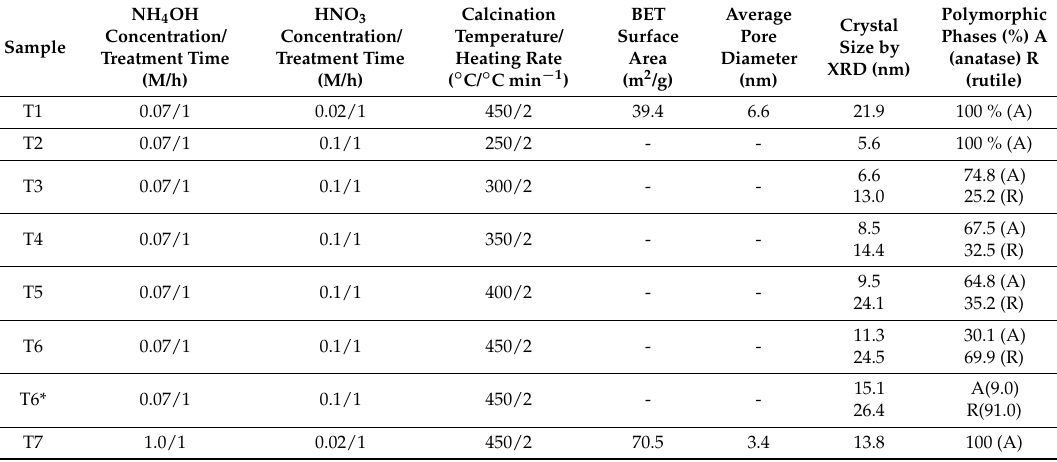
Table 2. BET surface area, average pore diameter, crystal size and percentage of polymorphic phases of titania for products hydrolyzed for 1 h with NH 4 OH 0.07 M or 0.1 M, subsequently treated or not